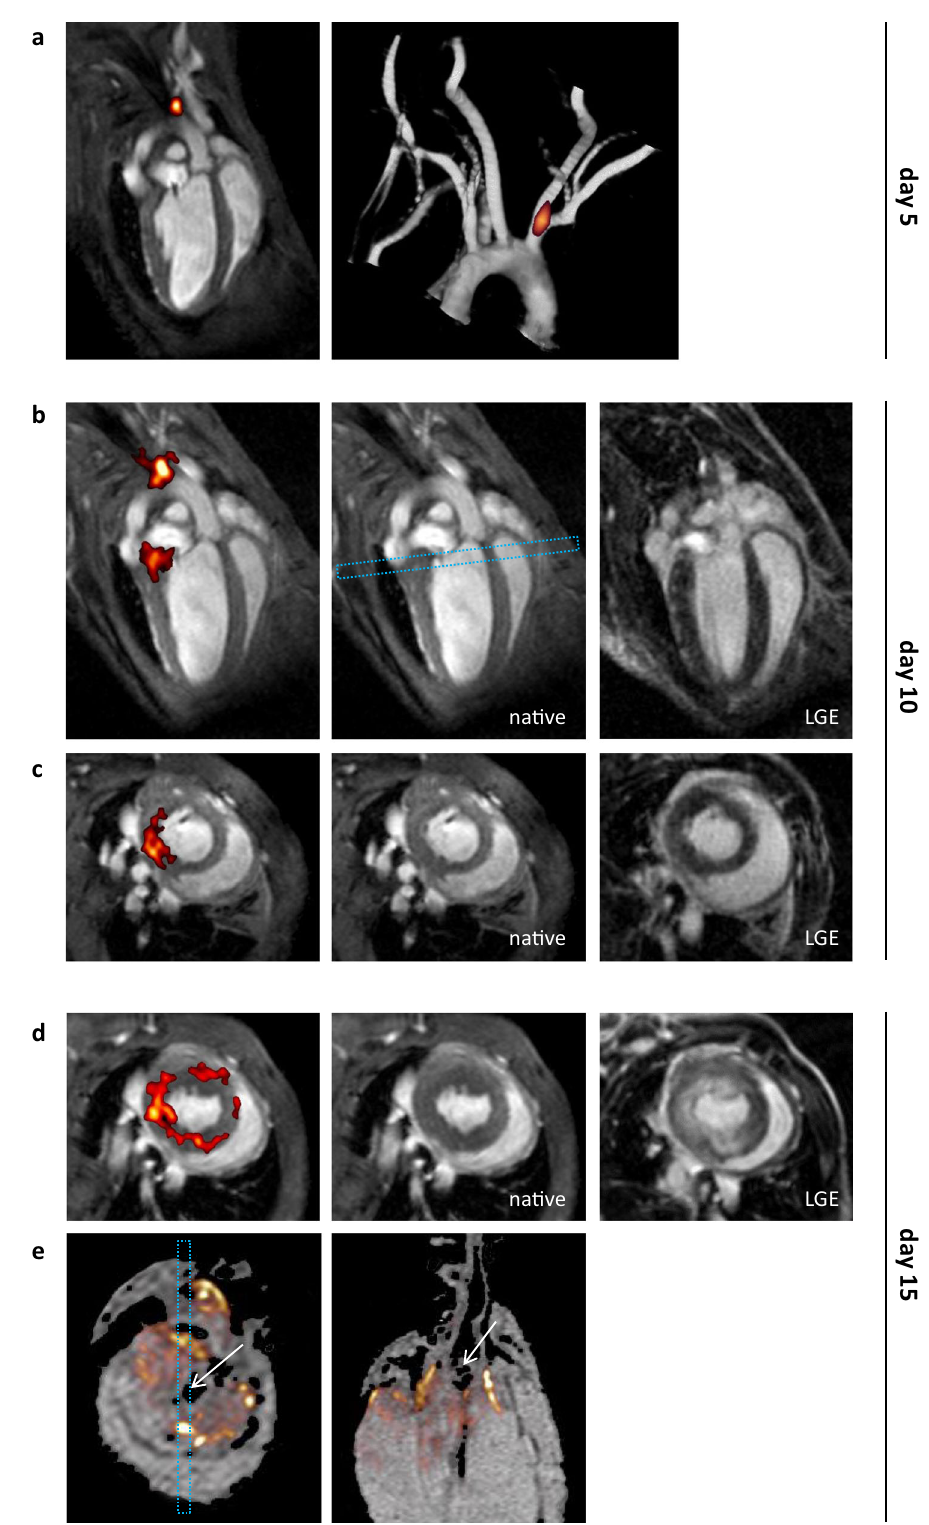
This sequence allowed us to speci fi cally detect all individual 19 F signals without any spill-over of neighboring 19 F peaks and to image the three per fl uorocarbons by simultaneous acquisition of fi ve distinct 19 F frequencies (Supplementary Table 1 and indicated by colored arrows in Fig. 2b left). As shown in Fig. 2c, 19 F mCSSI enabled artefact-free detection of both separated and mixed emulsions in the same experiment. For PFCE (red),